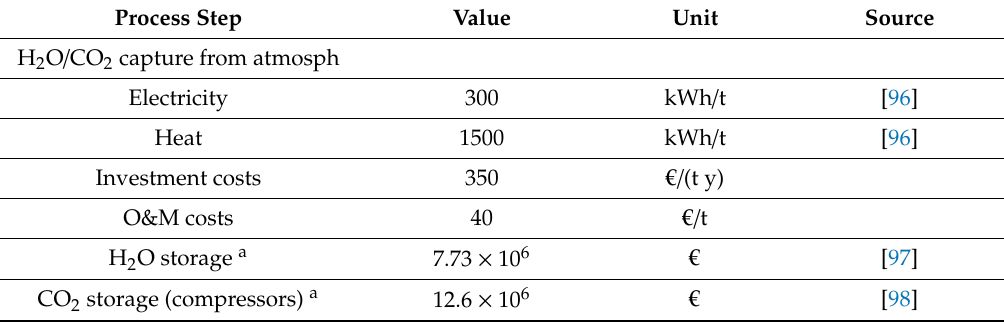
Table A6. Energy requirements, e ffi ciencies, and